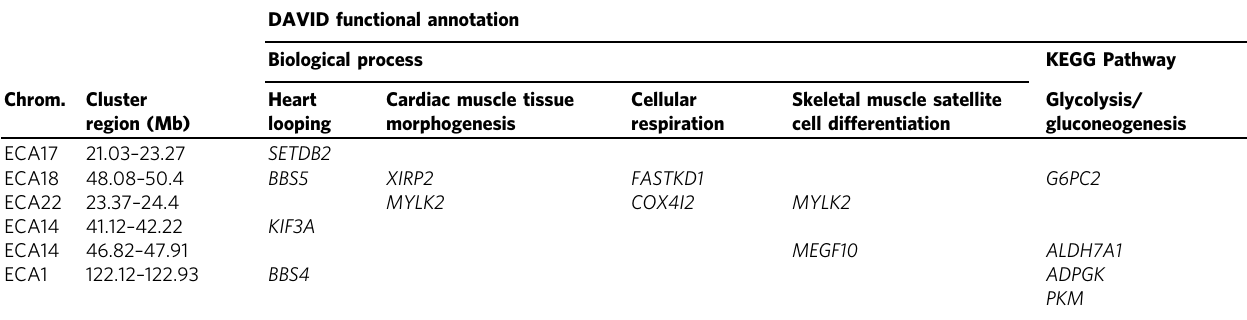
Table 2 Summary of exercise-relevant gene ontology terms enriched among genes in Racing selected regions.